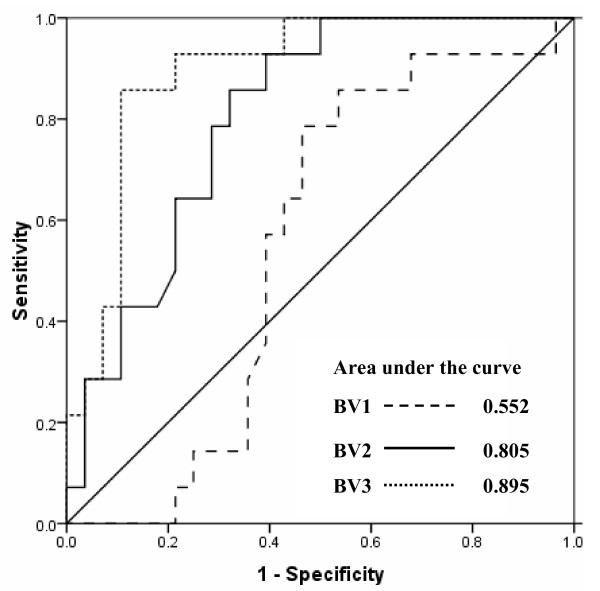
Receiver-operating characteristics (ROC) curves for predicting disease progression by plasma VEGF levels available before the start of therapy cycle 1 (BV1), cycle 2 (BV2), and cycle 3 (BV3).